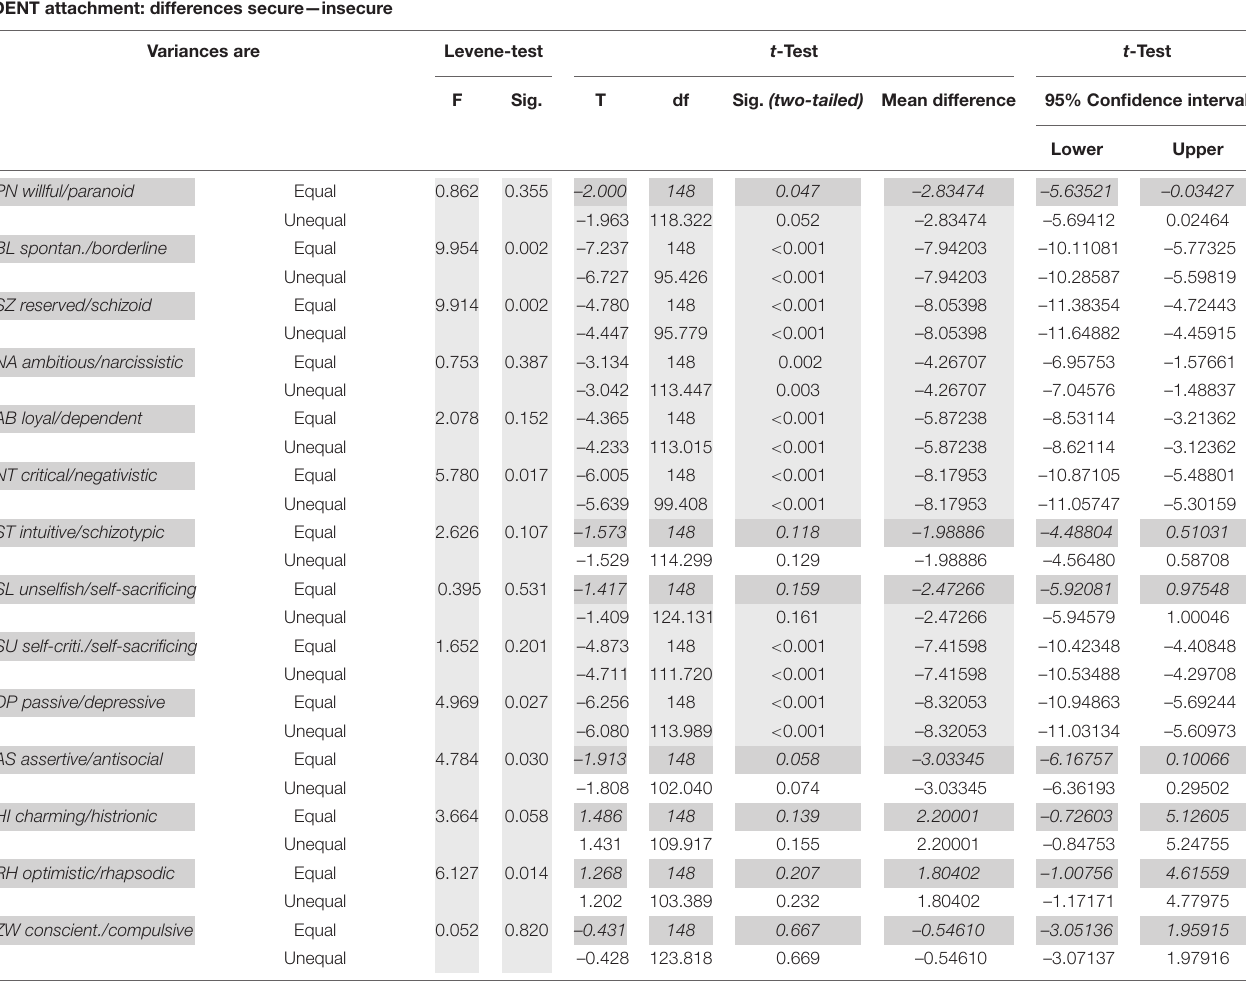
TABLE 4 | Test statistics for the differences between 90 securely and 60 insecurely attached NONHYP DENT participants in 14 personality styles of the PSDI. DENT attachment: differences secure—insecure Variances